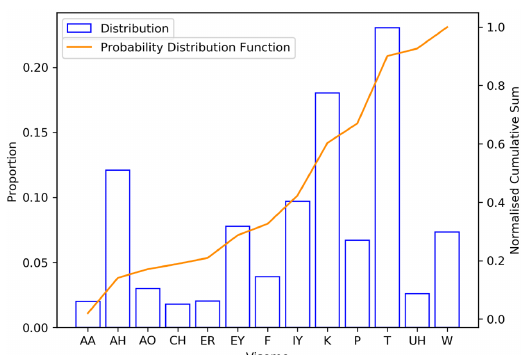
Figure 5. Probability distribution for generating